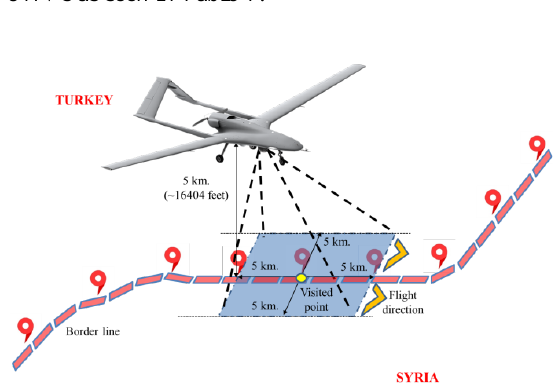
Figure 9. The usage of Bayraktar UAV for a border security